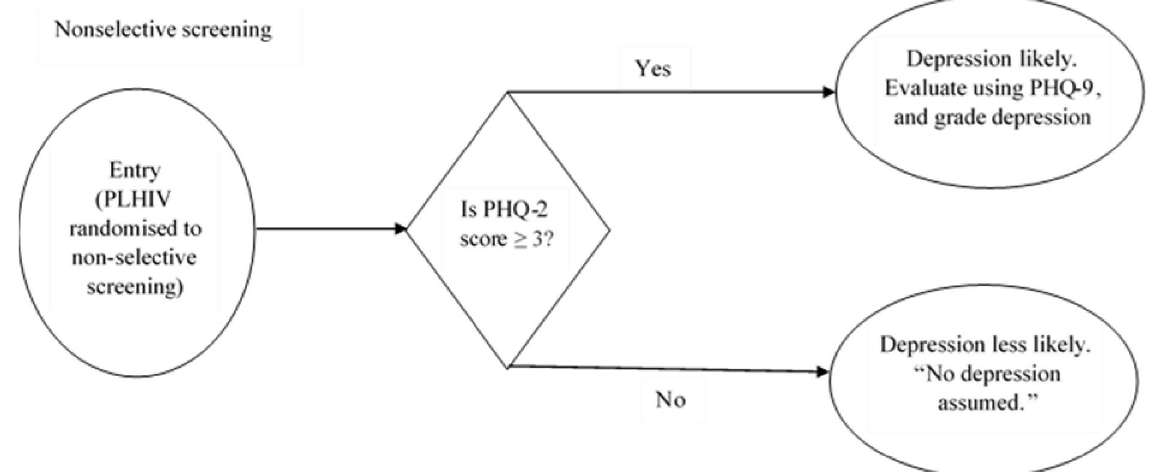
Fig 1. An illustration of non-selective screening strategy among